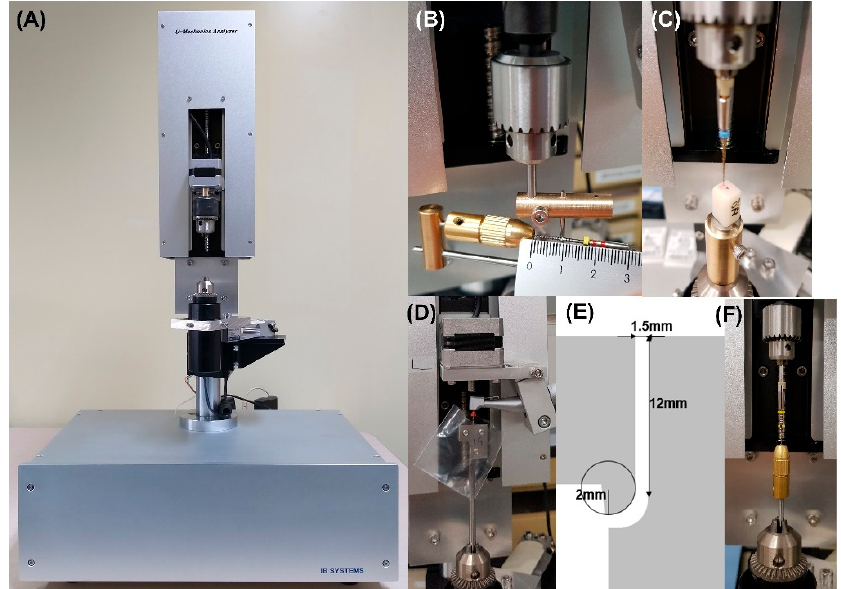
Figure 1. Experimental setup for mechanical testing. ( A ) A universal testing machine (Universal Mechanics Analyzer). Test setup for ( B ) bending, ( C ) buckling, and ( D ) cyclic fatigue resistance tests. ( E ) Schematic of the artificial canal used in the cyclic fatigue resistance test. ( F ) Test setup for the torsional resistance test.